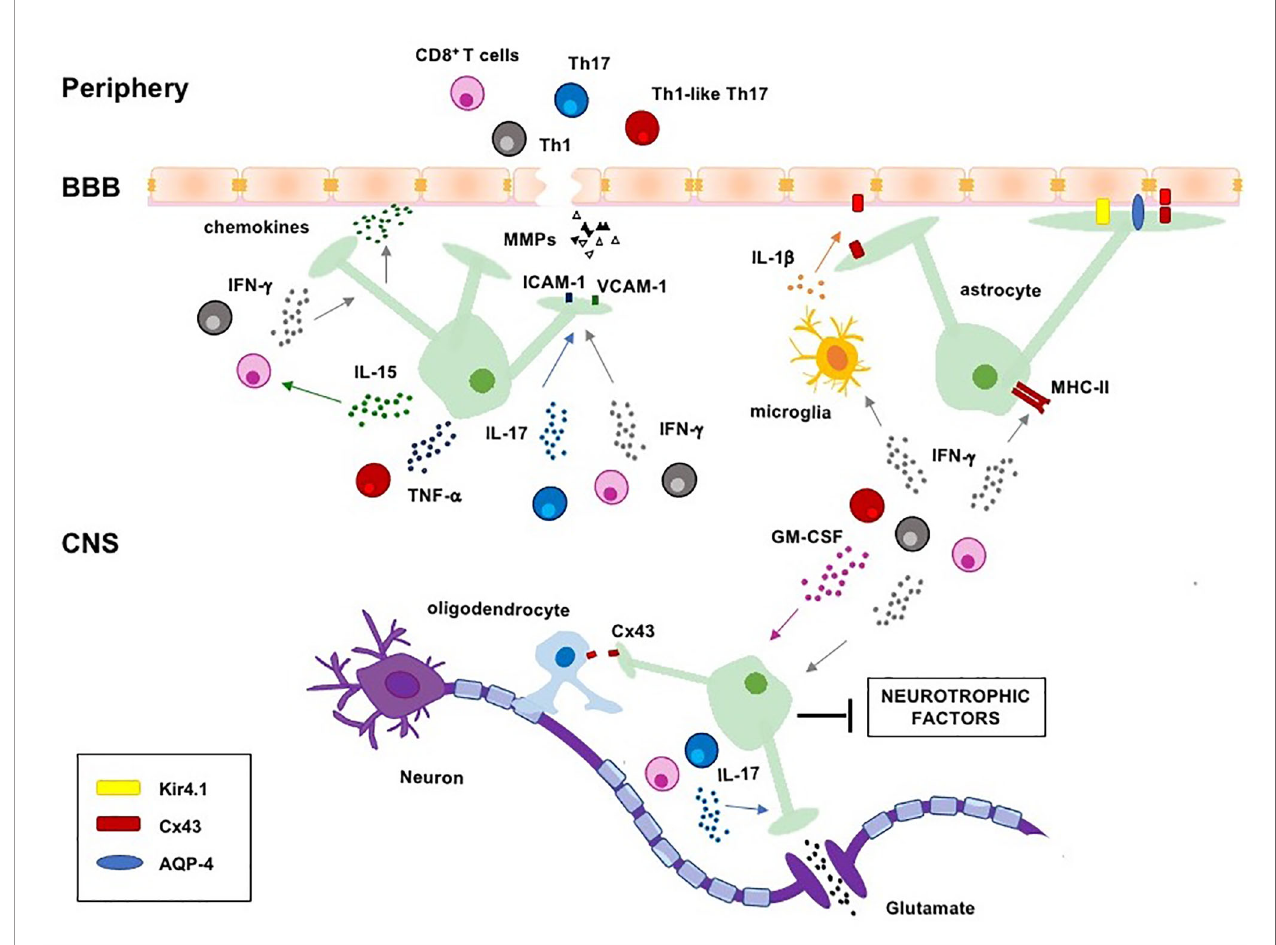
FIGURE 1 | Regulation of astrocyte functions by pathogenic T cells and lineage-de fi ning cytokines in MS. Pathogenic Th1, Th17, Th1-like Th17 and CD8 + T cells migrate into the CNS where they are reactivated and produce lineage-de fi ning cytokines, which induce astrogliosis and negatively regulate several homeostatic functions of astrocytes, such as the maintenance of BBB integrity, clearance of excessive ions and glutamate from the synaptic cleft, energy support to neurons and oligodendrocytes. CNS, central nervous system; BBB, blood-brain-barrier; MHC-II, major histocompatibility complex II; ICAM-1, intercellular adhesion molecule-1; VCAM-1, vascular adhesion molecule-1; AQP-4, aquaporin 4; Cx43, connexin 43; Kir4.1, inward rectifying potassium channel